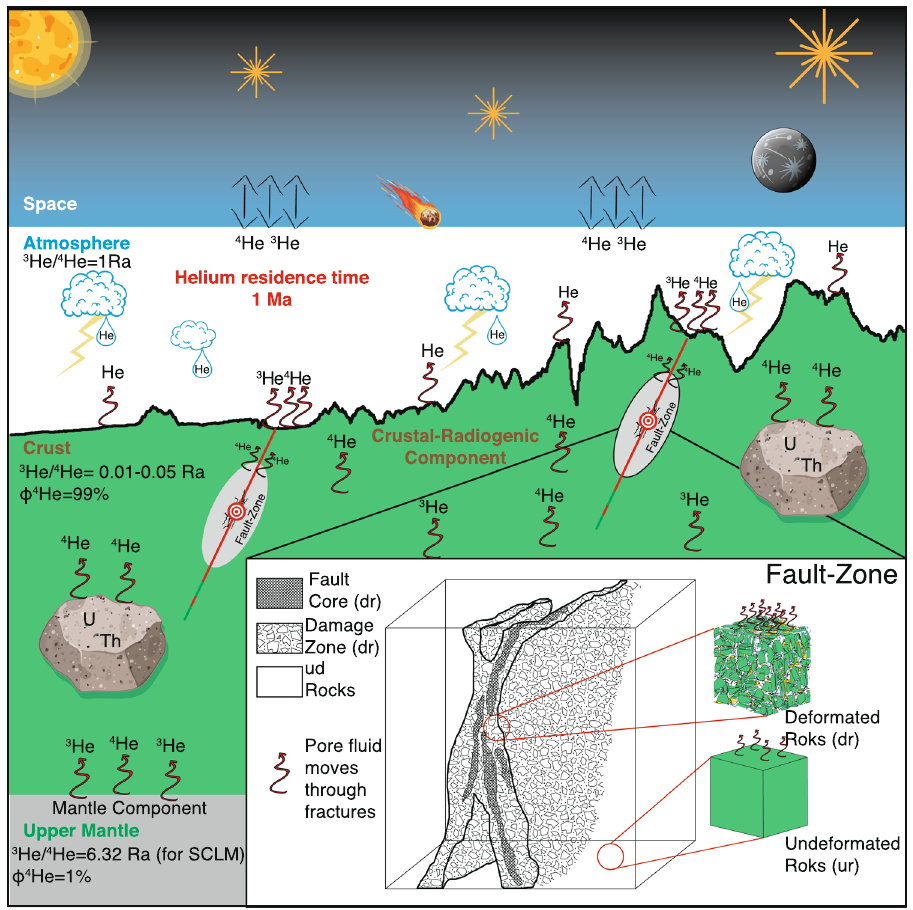
Fig. 1 Two-dimensional sketch of earth interior below continents and the atmosphere. Helium escapes from the continents to the atmosphere that exchanges it with space. In stable continental regions, the crustal radiogenic 4 He dominates the output of He and the mantle component is about 1% (more details are in text). In active tectonic regions, the faults are region of enhanced porosity and permeability and they are the network of pathways through which fl uids preferentially transfer to the atmosphere. Furthermore, the volumes of rocks that constitute the faults zones (damage zone plus fault core) are extensively deformed and fractured enhancing the release of crustal 4 He because of the volumetric stress change. The insert shows a zoomed schematic representation of the fault zones as fault core plus the damage zone and the adjacent un-deformed